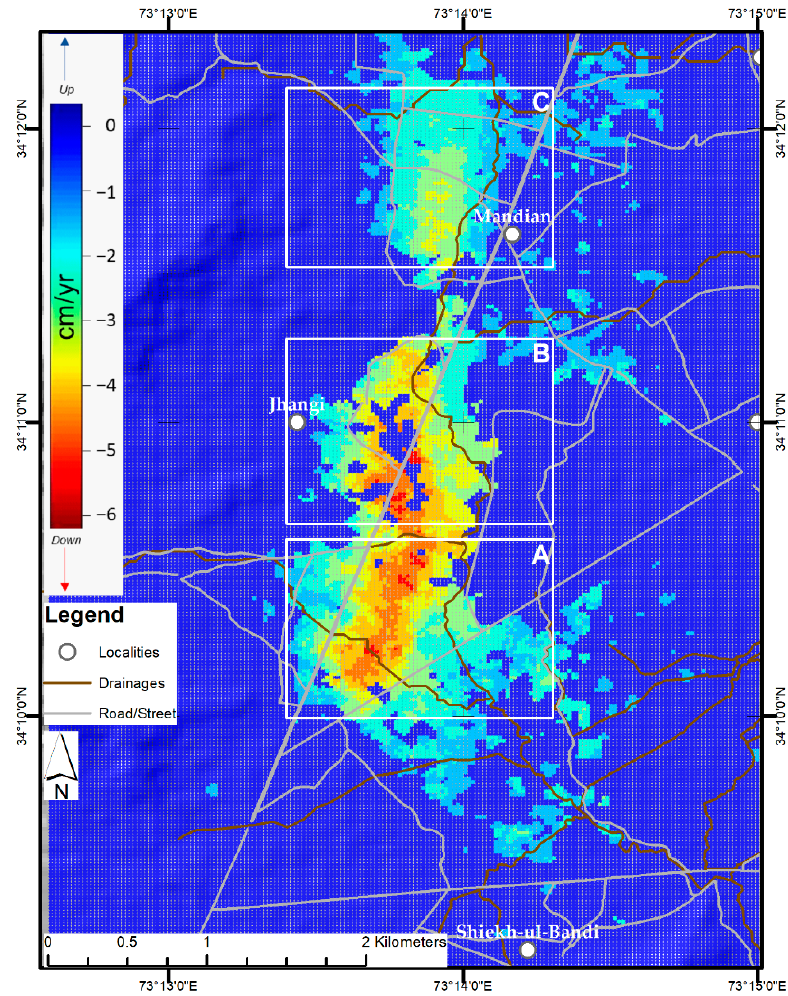
Figure 6. Mean vertical velocity map in cm / year. The red color represents downward movement (i.e., subsidence).